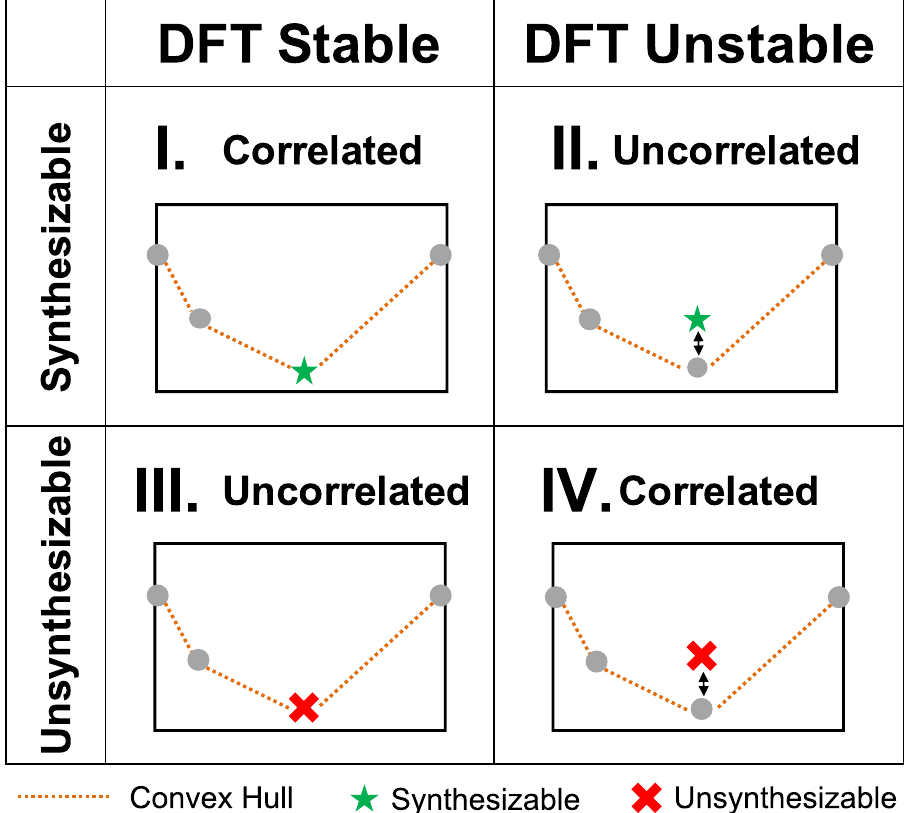
Fig. 1 Material classi fi cation matrix. A matrix for categorizing materials that have been attempted for synthesis based on their synthesizability and stability. Category I materials are stable and synthesizable; category II materials are unstable, yet synthesizable; category III materials are stable, yet unsynthesizable; category IV materials are unstable and unsynthesizable. Categories labeled “ correlated'' include materials whose stability directly describes their synthesizability. That is, materials are expected to be synthesizable if stable and are expected to be unsynthesizable if